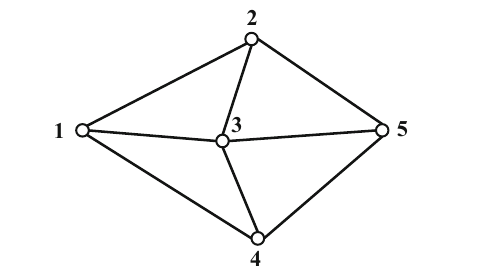
Fig. 6 The undirected network for Example 1